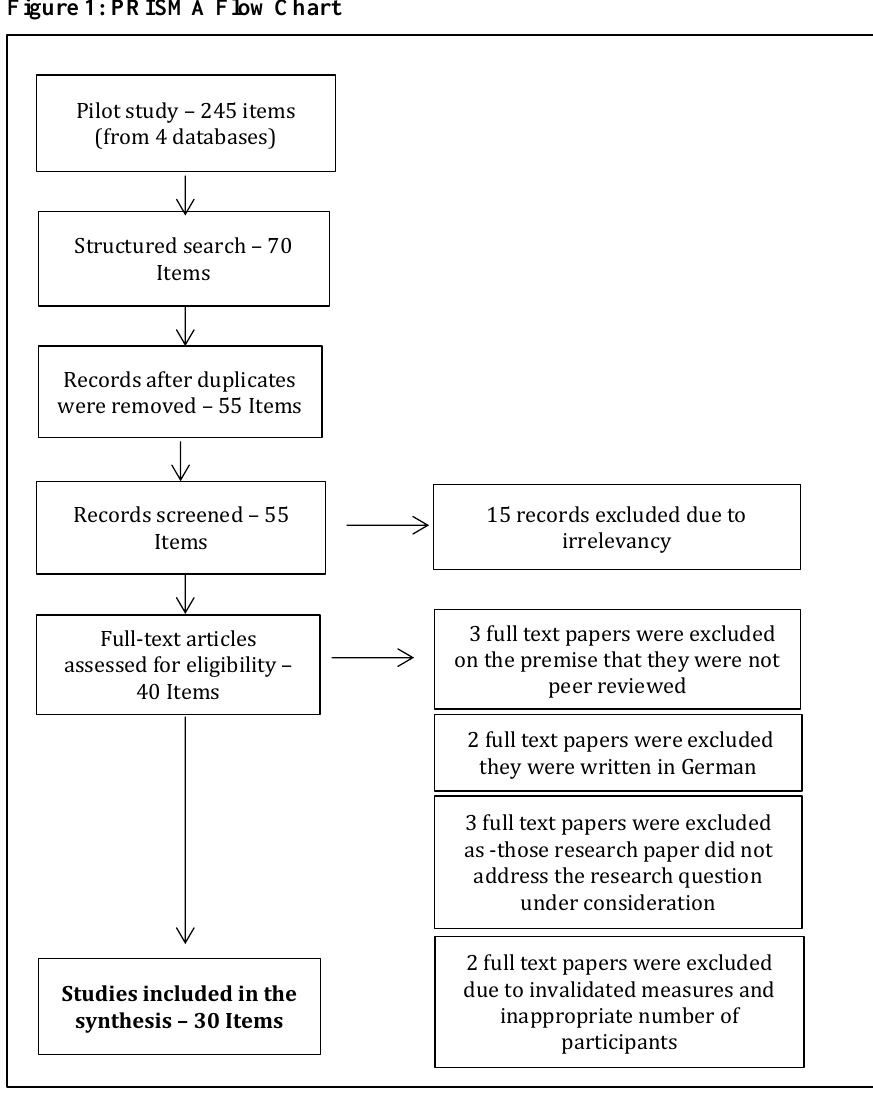
Figure 1: PRISMA Flow